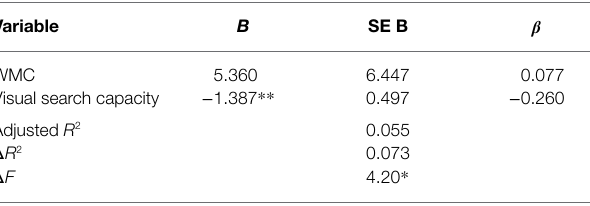
TABLE 6 | Summary of the standard multiple regression for resumption lag following 30-s